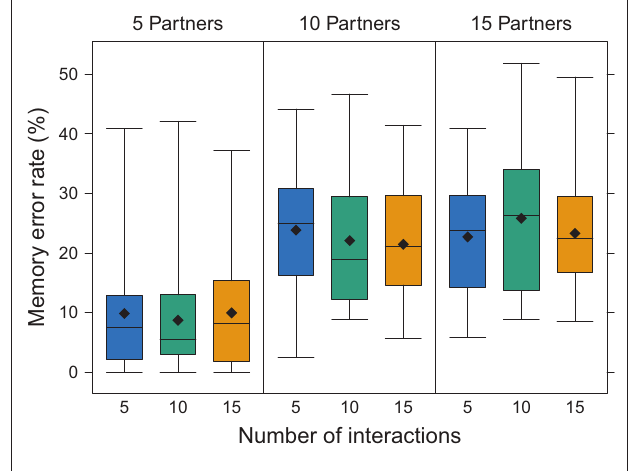
FIguRE 2 | Memory error rate as a function of partner number and number of interactions. Boxplots show that the error rate increased with group size ( N = 24 participants in each of nine conditions). The number of interactions per partner, however, did not influence error rate. Diamonds represent the mean, lines represent the median, boxes represent the interquartile range, and whiskers represent 1.5 times the interquartile range.